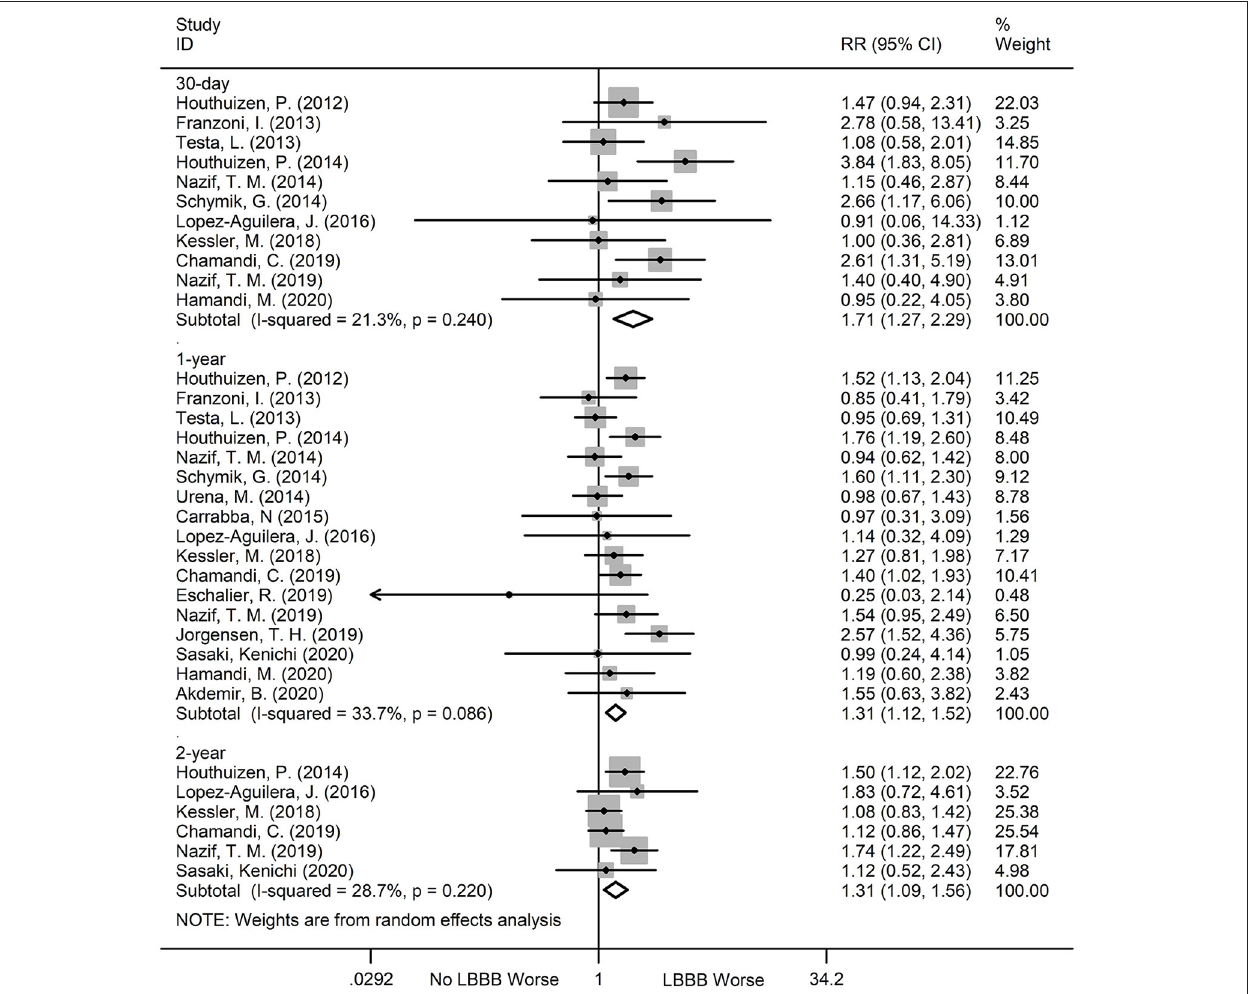
FIGURE 3 | Forest plot comparing all-cause mortality risk between patients with and without new-onset LBBB after